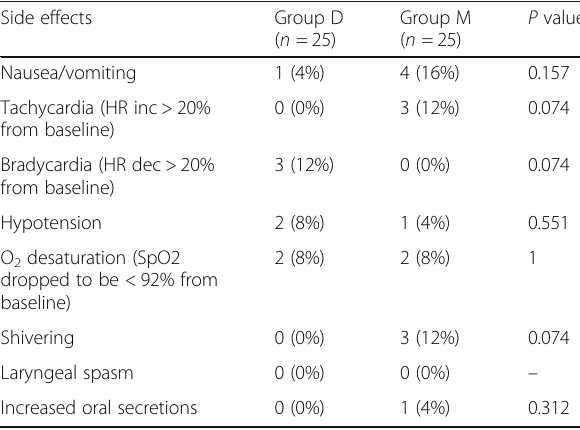
Table 9 The incidence of perioperative adverse events in both study